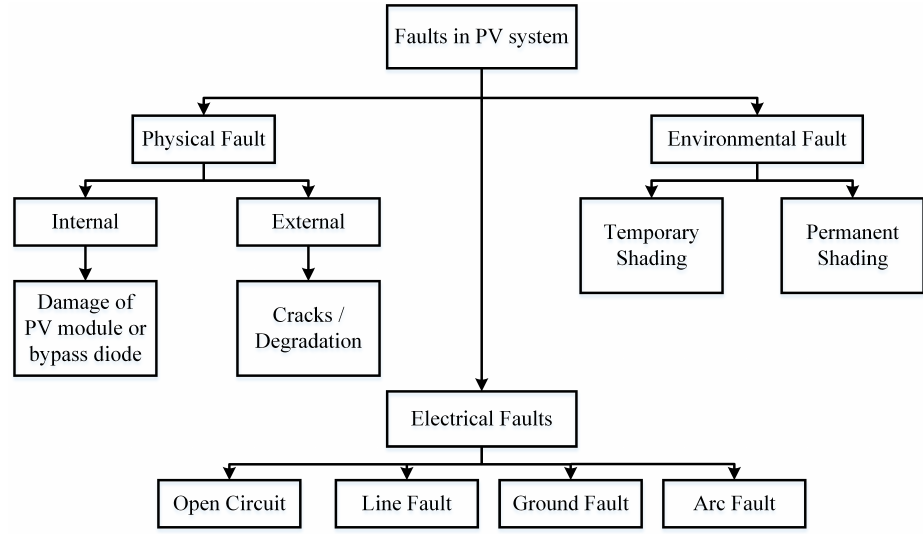
Figure 1. Classification of PV array